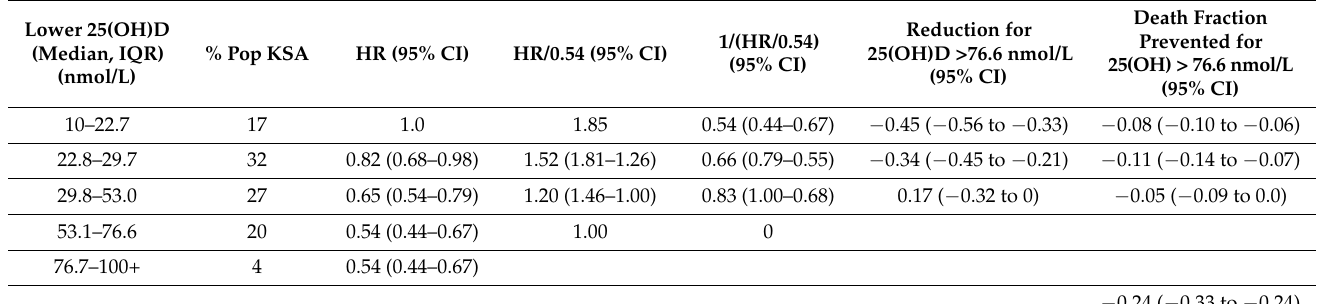
Table 9. Estimate of reduction in CVD mortality rate in the KSA by raising minimum 25(OH)D concentration to 30 ng/mL using 25(OH)D data from [86] and CVD results from the UK